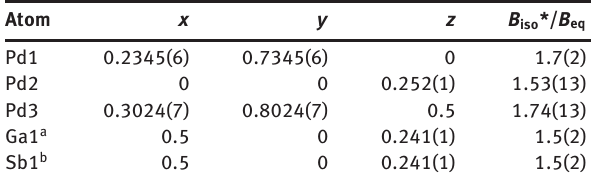
Table 2: Fractional atomic coordinates and isotropic or equivalent isotropic displacement parameters (Å 2